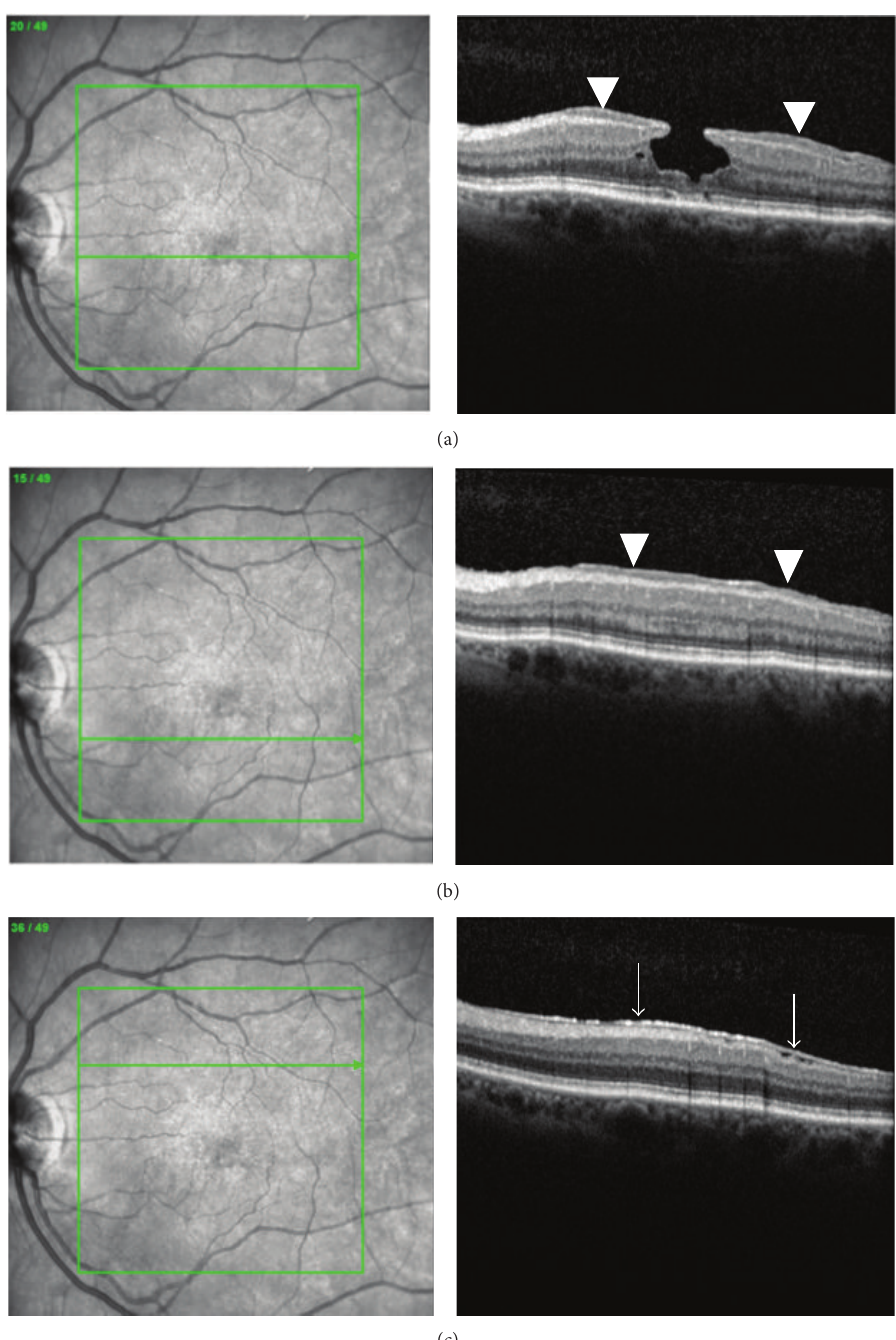
Figure 1: Spectral-domain optical coherence tomography images of a 73-year-old female with lamellar macular hole and lamellar hole- associated epiretinal proliferation (arrowheads) seen (a) at the macular defect and (b) in the parafoveal area. (c) A conventional epiretinal membrane (arrows) was found extrafoveal with some distance to the foveal